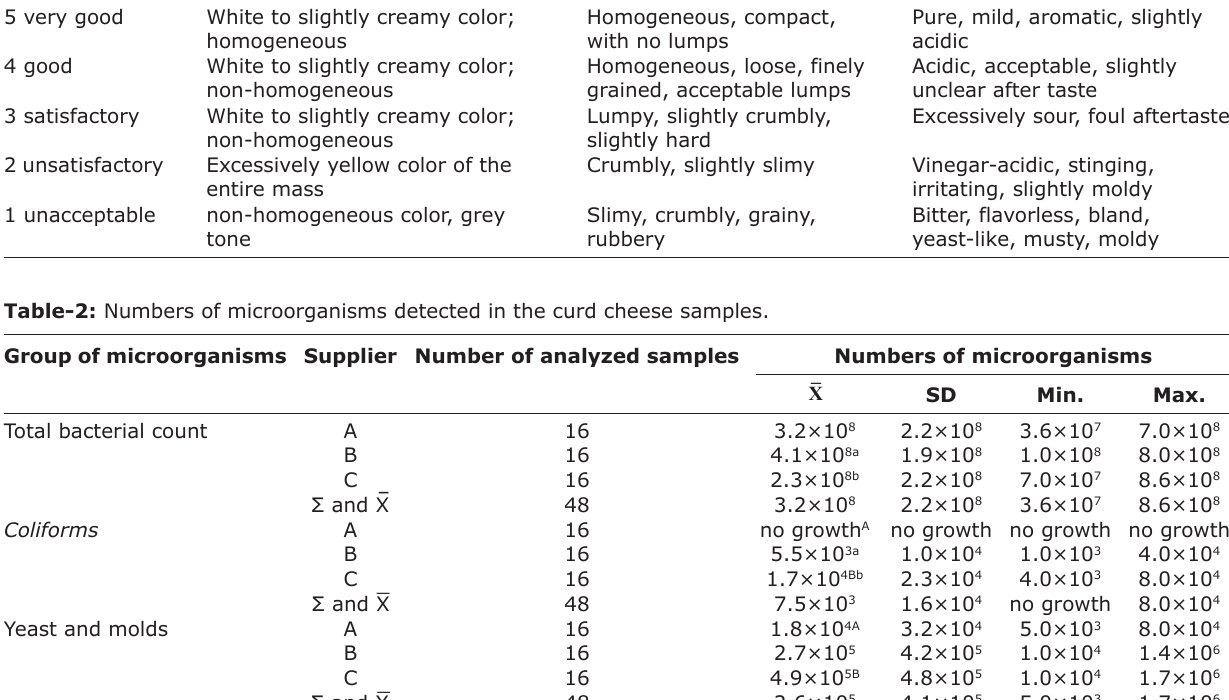
Table-1: Scores of curd cheeses in a 5-point scale [25]. Scores Appearance and colour (0.15)